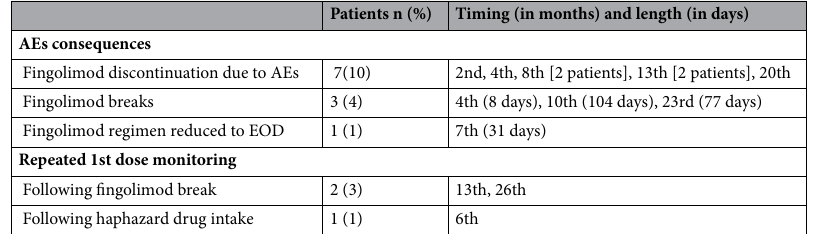
Patients n (%) Timing (in months) and length (in